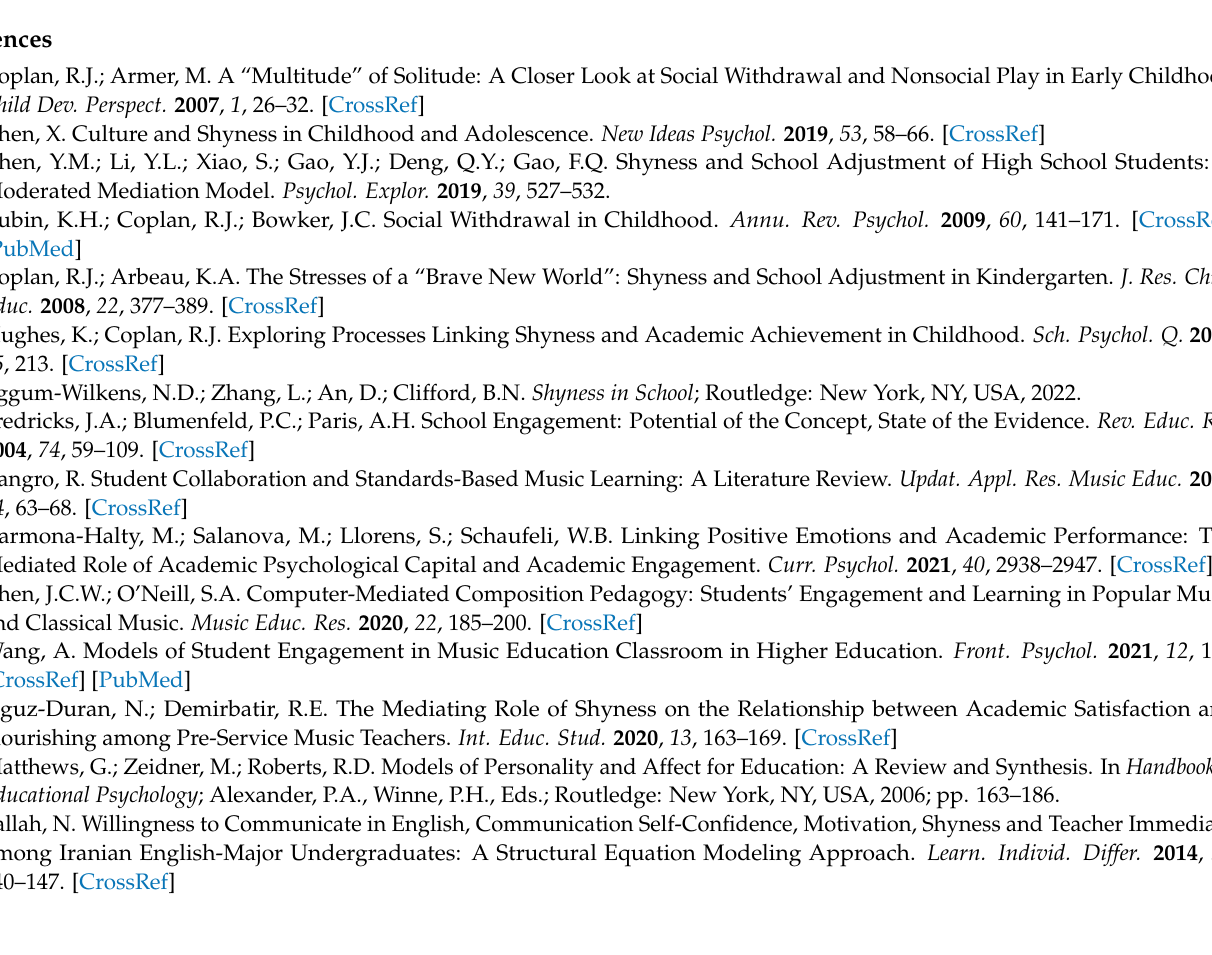
Table S2: The descriptive statistics of